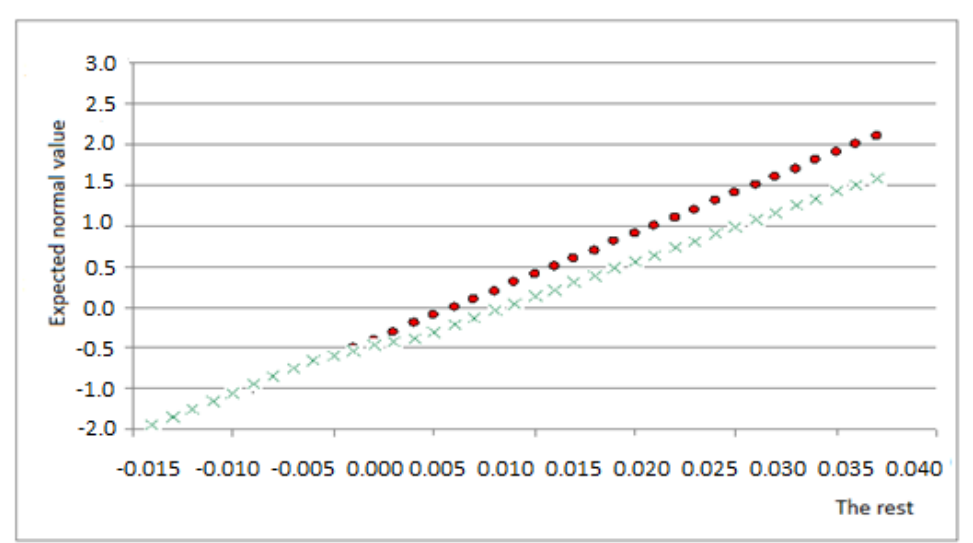
Figure 3. The plot of the normality of the residuals of the model. Source: own study.